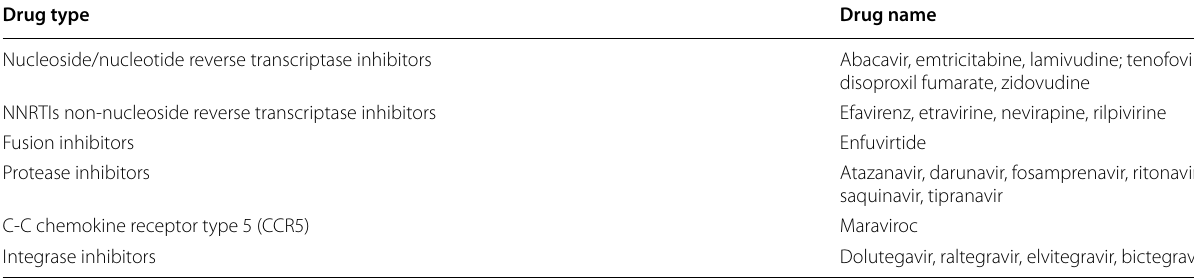
Table 1 Food and Drug Administration (FDA)-approved small molecule HIV therapeutics Drug